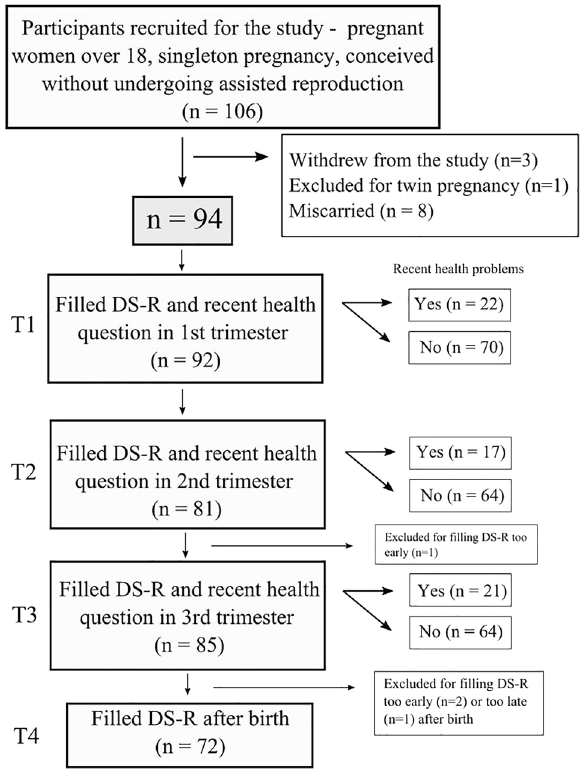
Figure 1. A chart detailing the number of participants in each part of the